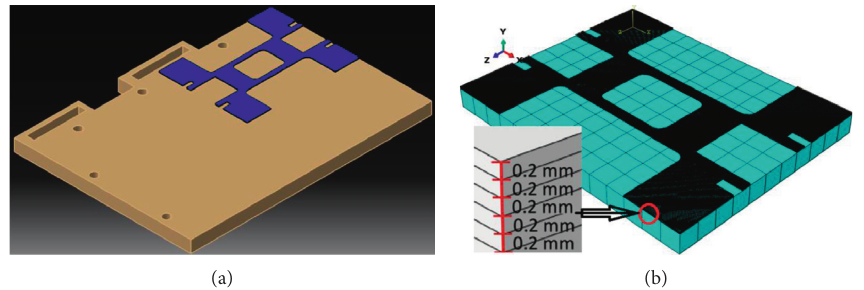
Figure 14: (a) Layer orientation; (b) meshing strategy.